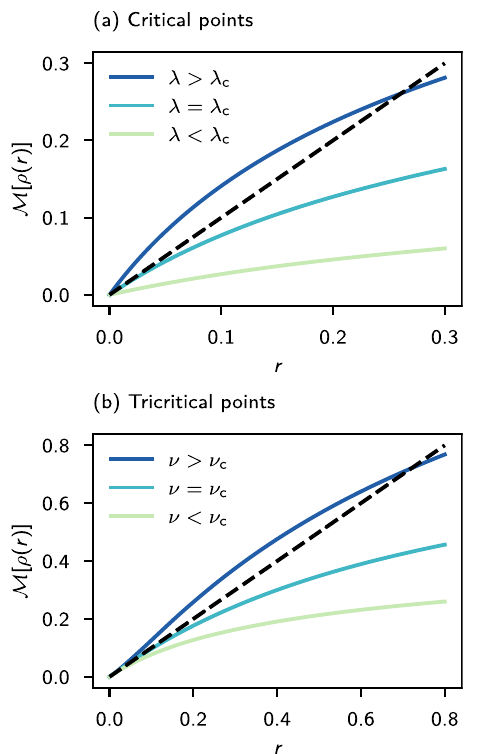
Fig. 4 Critical behavior of the function M ½ ρ ð r Þ(cid:3) . Each intersection with the dashed line represents a stationary solution of Eqs. (7a)-(7b). Results refer to the infection rate function β ( n , i ) = λ i ν and a hypergraph with g m = ( δ m ,2 + δ m ,3 )/2 and p n = ( δ n ,4 + δ n ,5 )/2. a We fi x ν = 1 and vary λ . For λ > λ fi x λ = λ ν . Note that the c , a nontrivial solution emerges. b We c and vary slope of all solid lines is 1 at the origin. A nonlinear exponent ν > ν c is associated M > 0 in this with a discontinuous phase transition, since ∂ 2 r